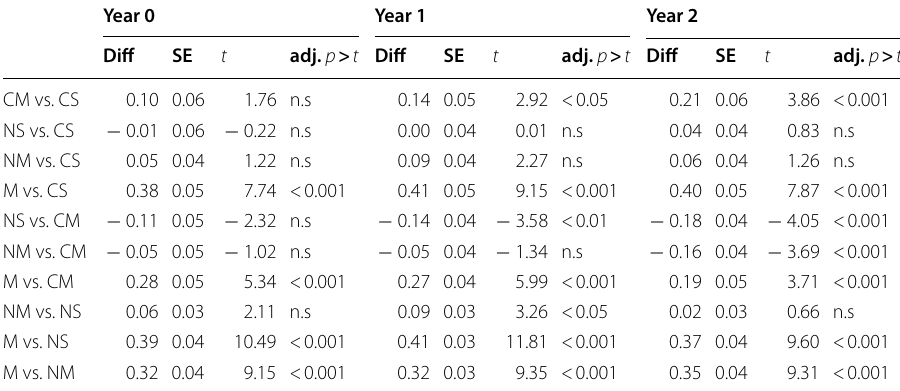
Table 4 Comparison of AQI means by type and year with adjustment for unequal variances and sample sizes with Tamhane’s